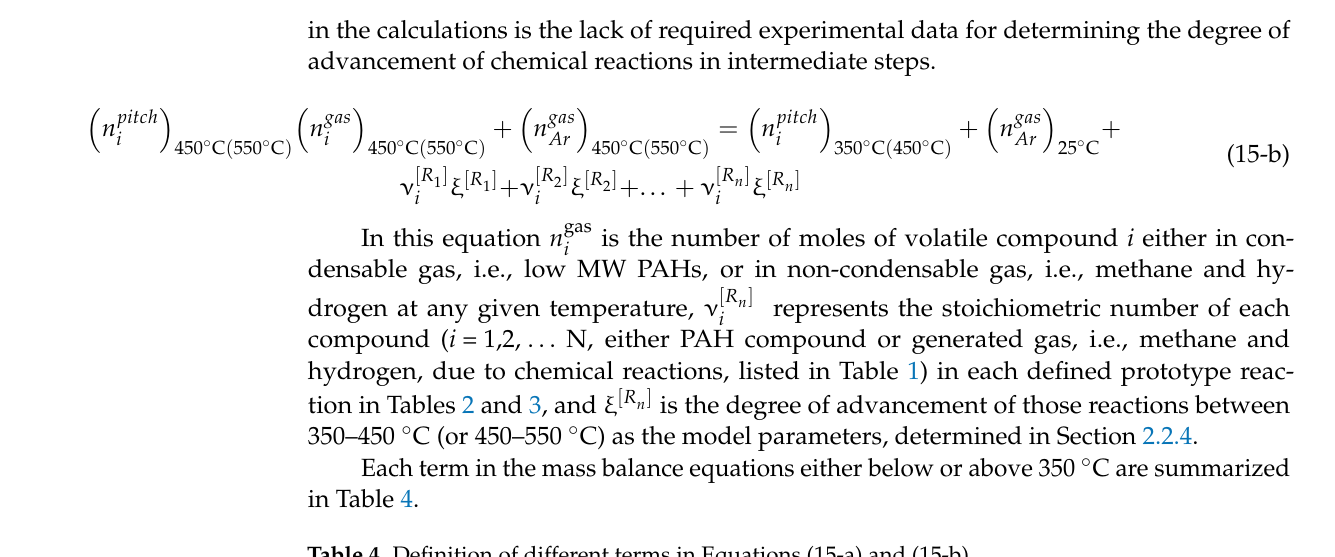
Table 4. Definition of different terms in Equations (15-a) and